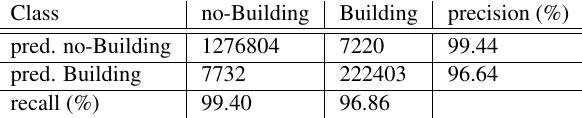
Table 2. Results of the point-based classification of building and no-building points.